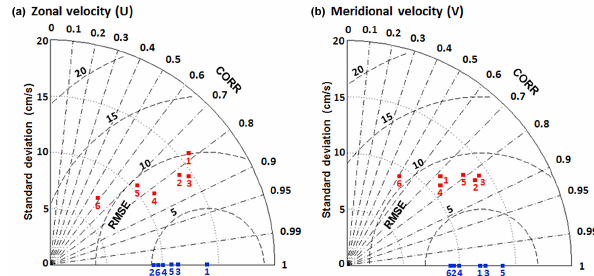
Figure 7. Taylor diagrams, based on the law of cosines, provide a concise statistical summary of how closely unfiltered hourly radar estimations (red filled squares) match with B1 observations (blue filled squares), considered here as the reference points of perfect agreement. Taylor diagrams for zonal (a) and meridional (b) veloc- ity components gather the monthly statistical metrics derived from HF radar–B1 comparison. Sequential numbers refer to individual months of the analyzed period May–October 2014 (1: May; 6: Oc-